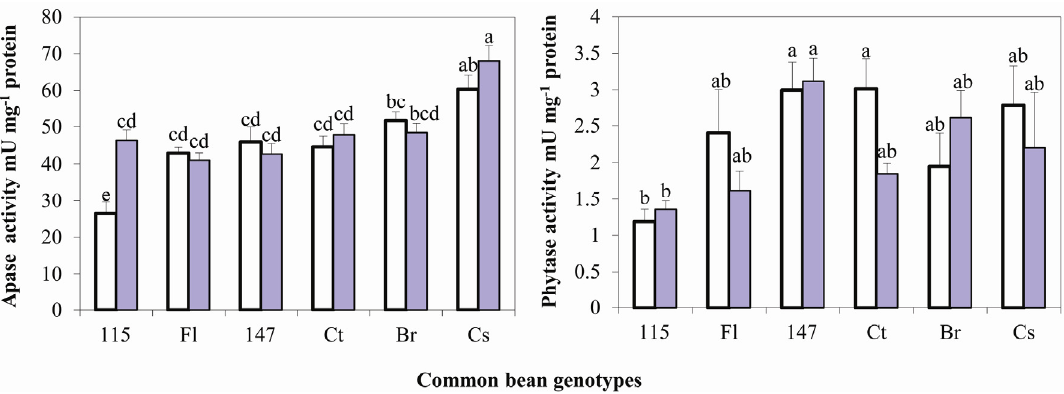
Figure 3. Enzyme activities of APase ( a ) and phytase ( b ) in rhizospheric soil of six common bean genotypes grown under sufficient P ( empty bar ) versus low P ( filled bar ) soil. Data are means ± se of six replicates harvested at flowering stage.